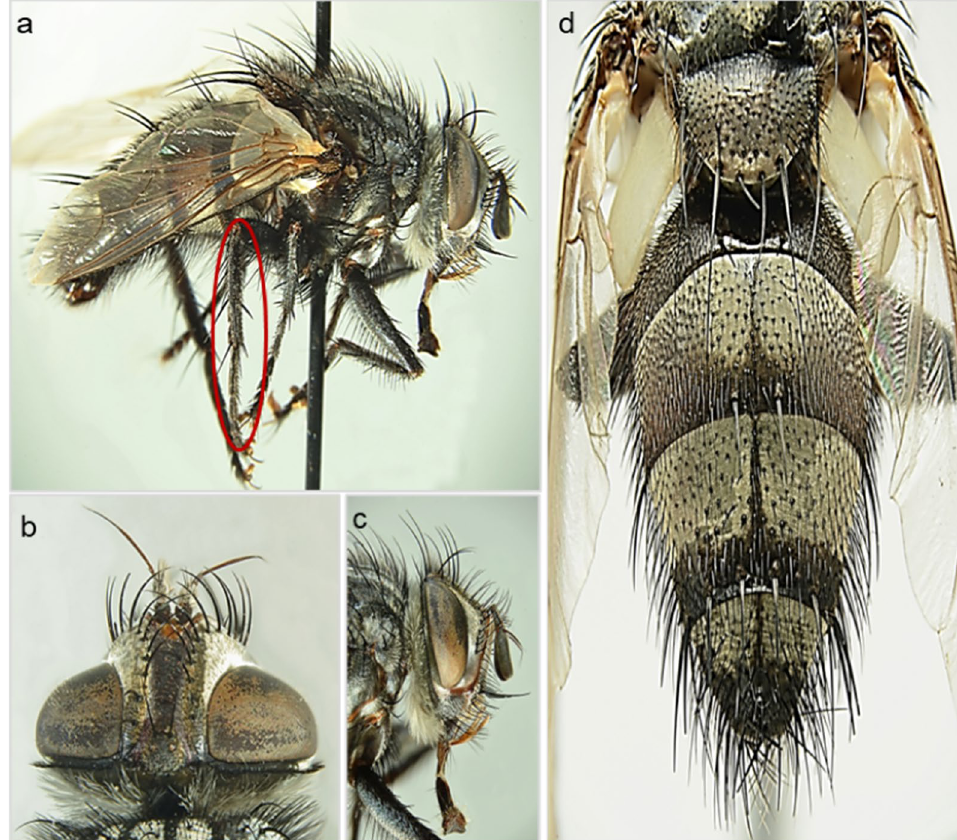
Fig.1 Exorista segregate (male): a adult; b head and eyes; c ocellar bristles; d